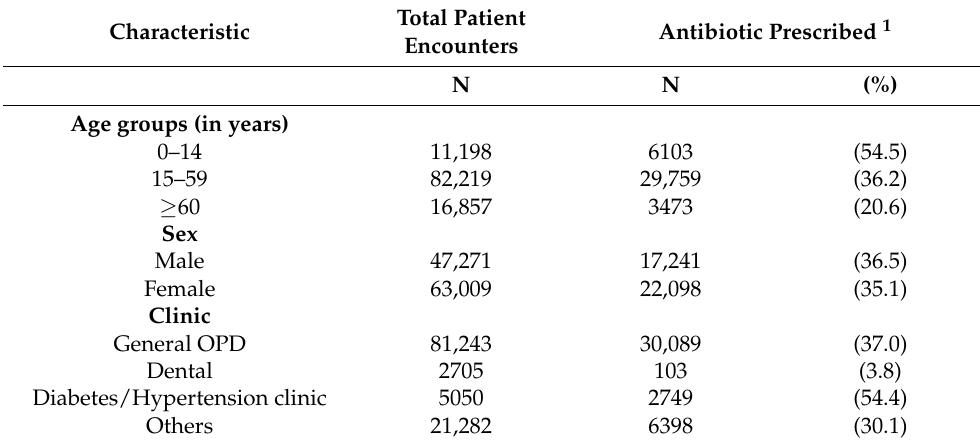
Table 2. Patient encounter characteristics associated with antibiotic prescriptions in the outpatient department of University Hospital, KNUST, in Ghana between January and December 2021.